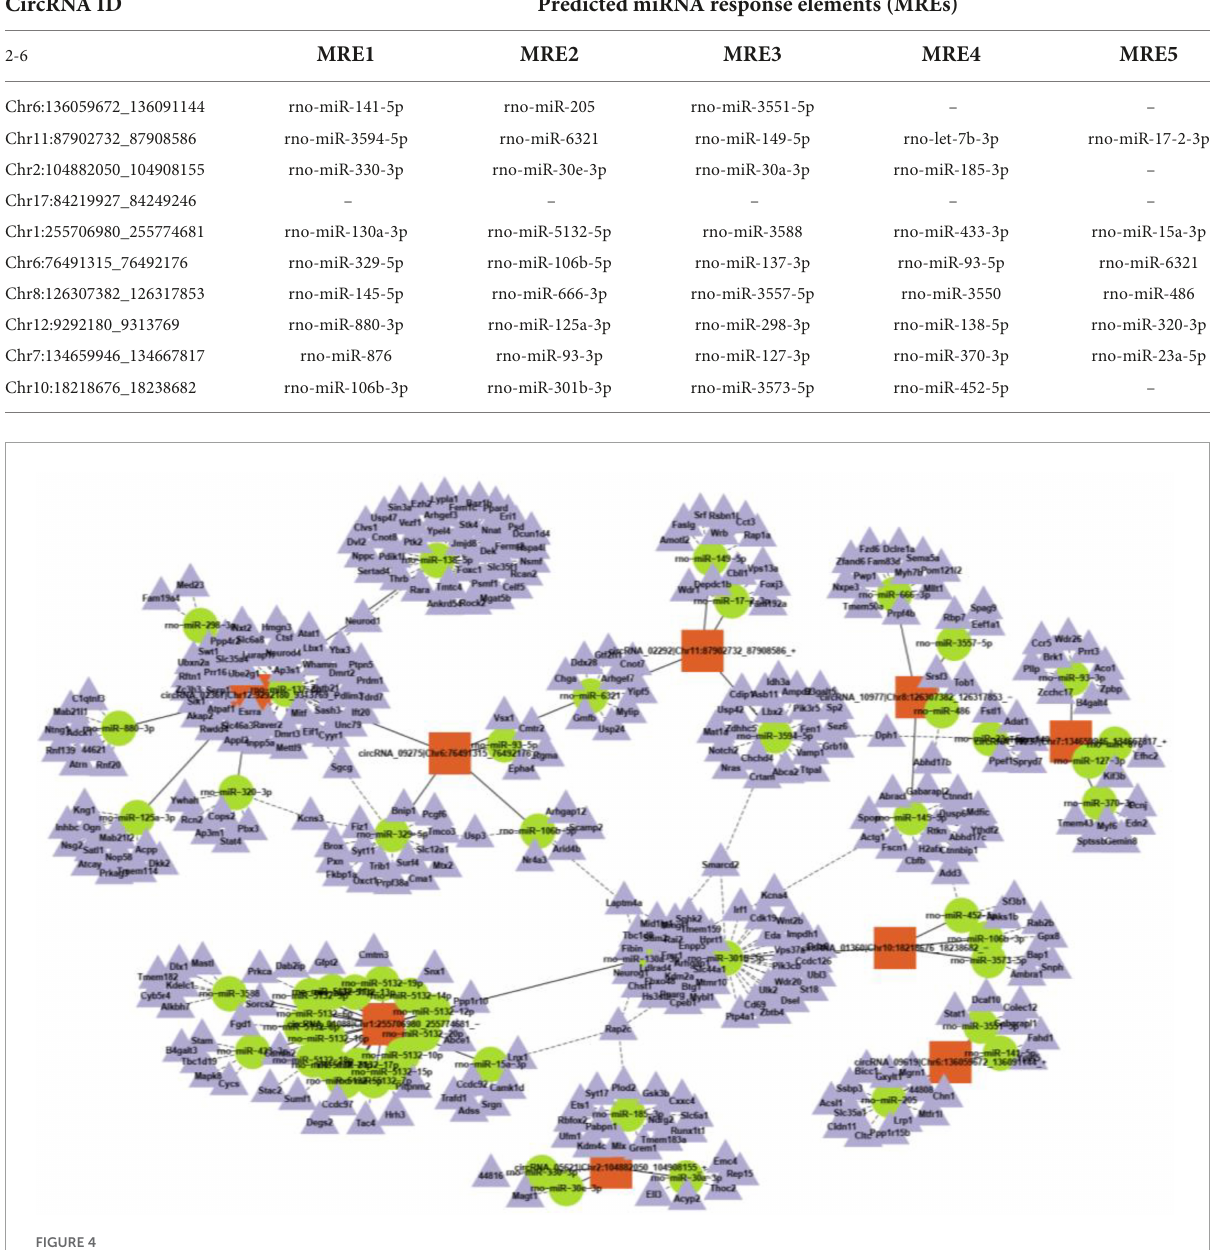
FIGURE4 A representative circRNA-miRNA-mRNA coexpression network was obtained by OmicStudio